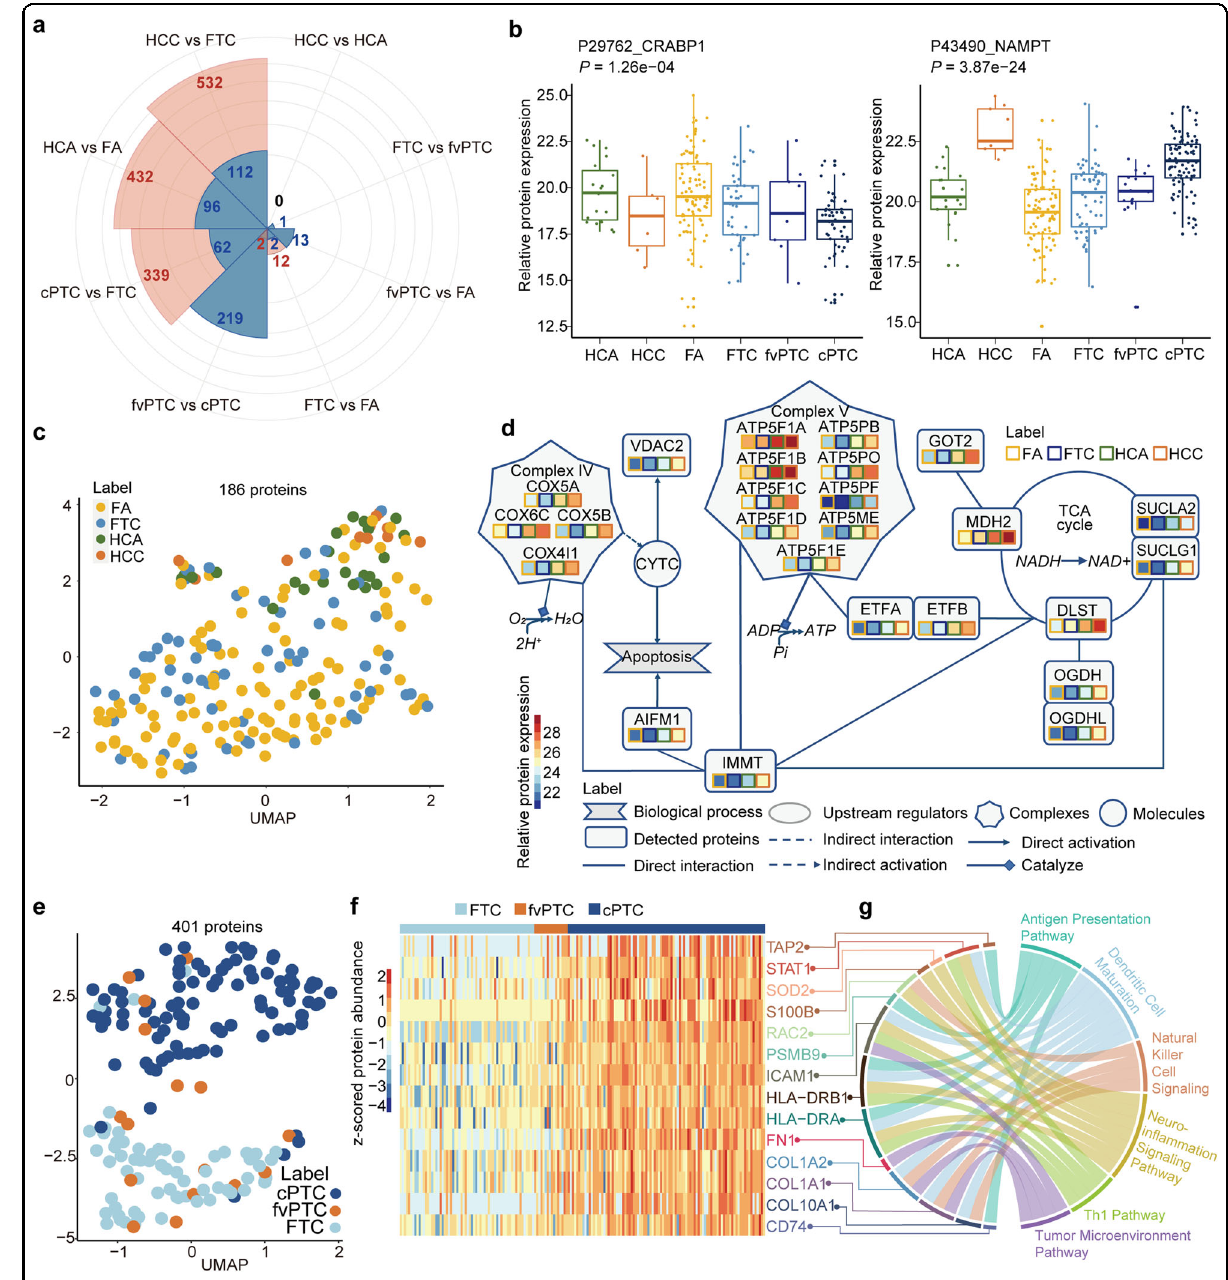
Fig. 5 Biological insights of thyroid tumor subtypes based on proteotypic data. a Rose chart plotting the DEP counts of corresponding pairwise comparison for follicular-pattern tumors and control samples (cPTC). The threshold that we used was fold change> 4 and adjusted P -value <0.01. The pink and blue colors represent counts of upregulated and downregulated proteins in the Rose chart, respectively. b Box plots showing CRABP1 and NAMPT dysregulated in six histological tumor subtypes, especially between FTC and FA. P -values were calculated by one-way ANOVA for six-group comparison in the box plots. c UMAP plot for 186 proteins distinguishing Hürthle cell tumors from other follicular neoplasms. d Network map showing expression of key mitochondrial proteins implicated in Hürthle cell neoplasms. e UMAP plot for 401 proteins distinguishing FTC from cPTC, with fvPTC as an intermediate phenotype. f , g Heatmap showing DEPs ( f ) in FTC compared with fvPTC and cPTC, with pathways ( g ) indicated in the chord